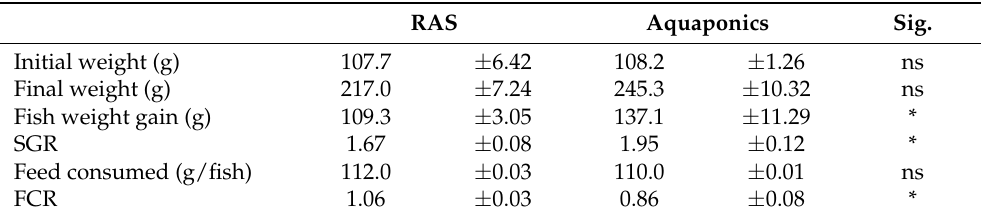
Table 1. Initial and final wet weight, fish weight gain, specific growth rate (SGR), feed consumed, and feed conversion ratio (FCR) of rainbow trout ( Oncorhynchus mykiss ), grown in RAS and aquaponic systems for 42 days. In the aquaponics treatment rainbow trout was grown in a coupled aquaponic system with spinach ( Spinacia oleracea ). RAS Aquaponics Sig. Initial weight (g) 107.7 ± 6.42 108.2 ± 1.26 ns Final weight (g) 217.0 ± 7.24 245.3 ± 10.32 ns Fish weight gain (g) 109.3 ± 3.05 137.1 ± 11.29 * SGR 1.67 ± 0.08 1.95 ± 0.12 * Feed consumed (g/fish) 112.0 ± 0.03 110.0 ± 0.01 ns FCR 1.06 ± 0.03 0.86 ± 0.08 * Values are means ± SD, n = 3. Statistical difference (Sig.) in the values between aquaponics and RAS treatments is shown by an asterisk * ( p < 0.05), ns = not significant. The mean dry weights for shoot, root, total dry weights, shoot to root ratio, mean